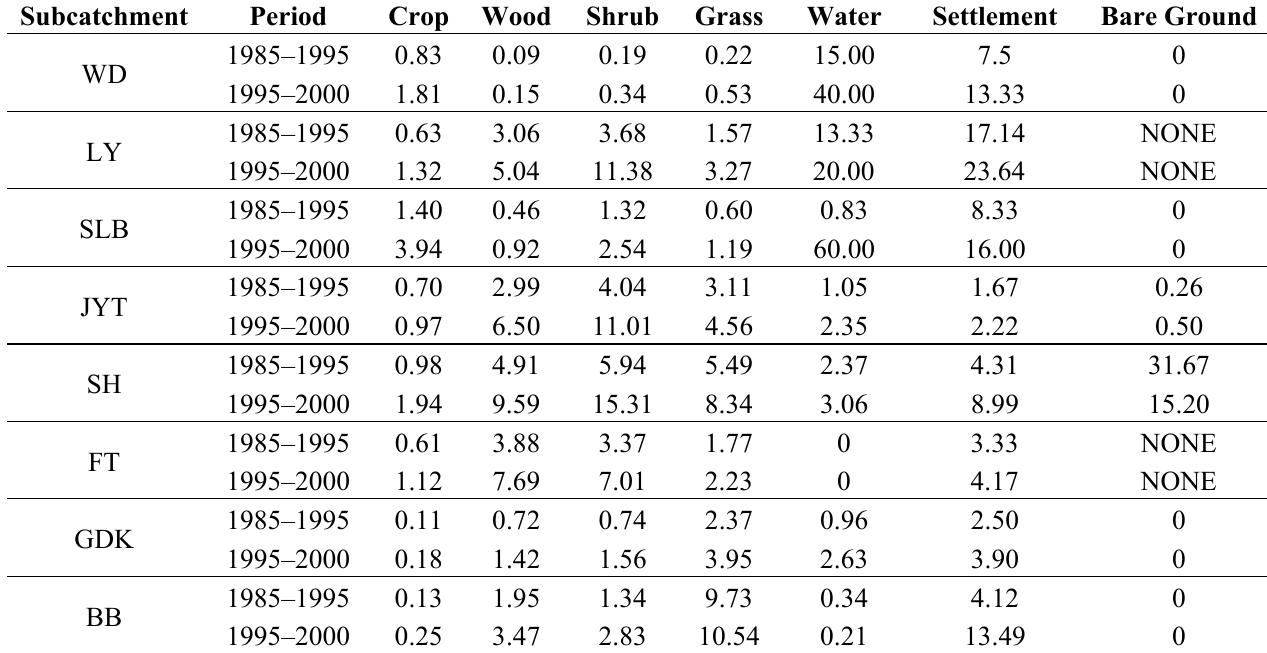
Table 7. Degrees of the single land use dynamics by subcatchment.